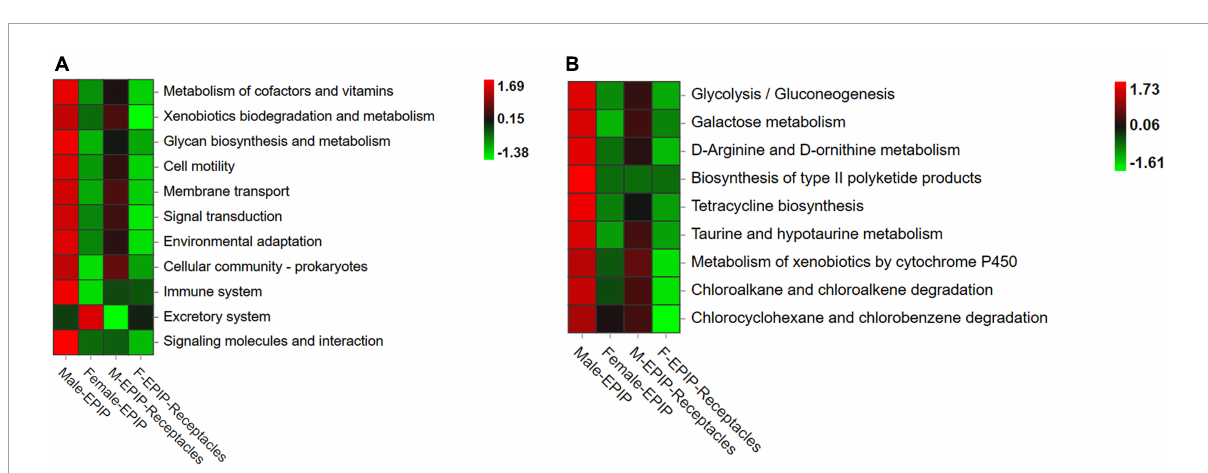
FIGURE7 Functional prediction of partial genes of epiphytic bacteria on algal bodies and receptacles of male and female S. thunbergii . (A) Level_2 level. (B) Level_3